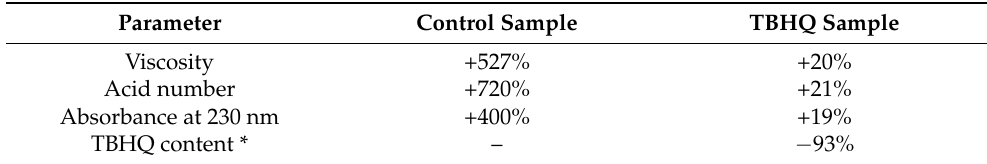
Table 7. The effect of the optimum TBHQ addition on quality parameters of biolubricant after oxidation (8